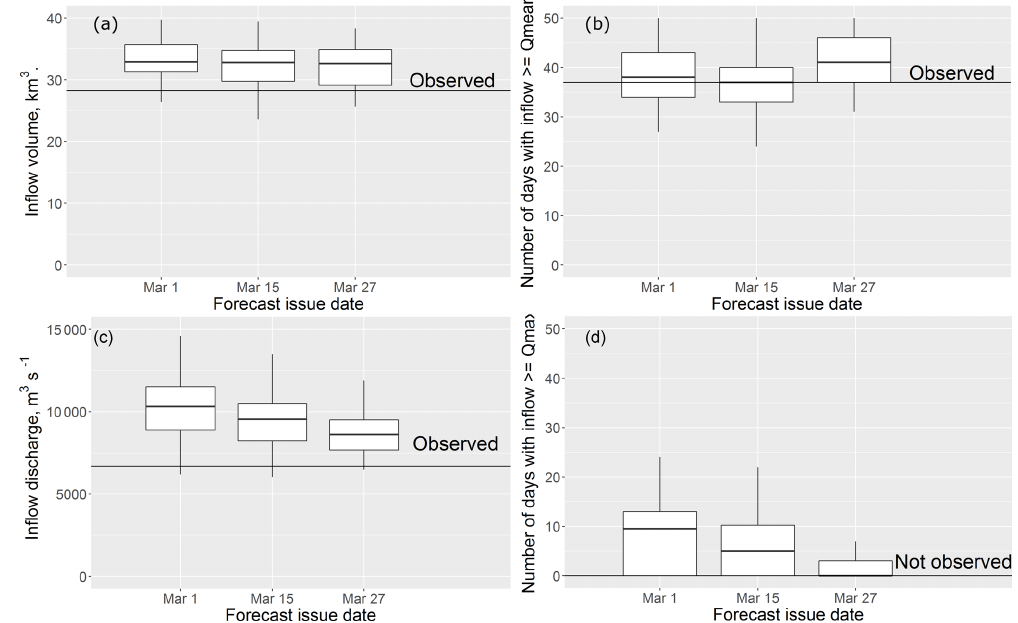
Figure 7. Box plots of the ESP-based forecast of the inflow volume (a) , the number of days with the inflow discharge above the mean observed discharge (b) , the maximum inflow discharge (c) and the number of days with inflow discharge above the mean maximum ob- served discharge (d) for the period from 1 April till 30 June 2017. The solid horizontal line shows the observed value of the corresponding